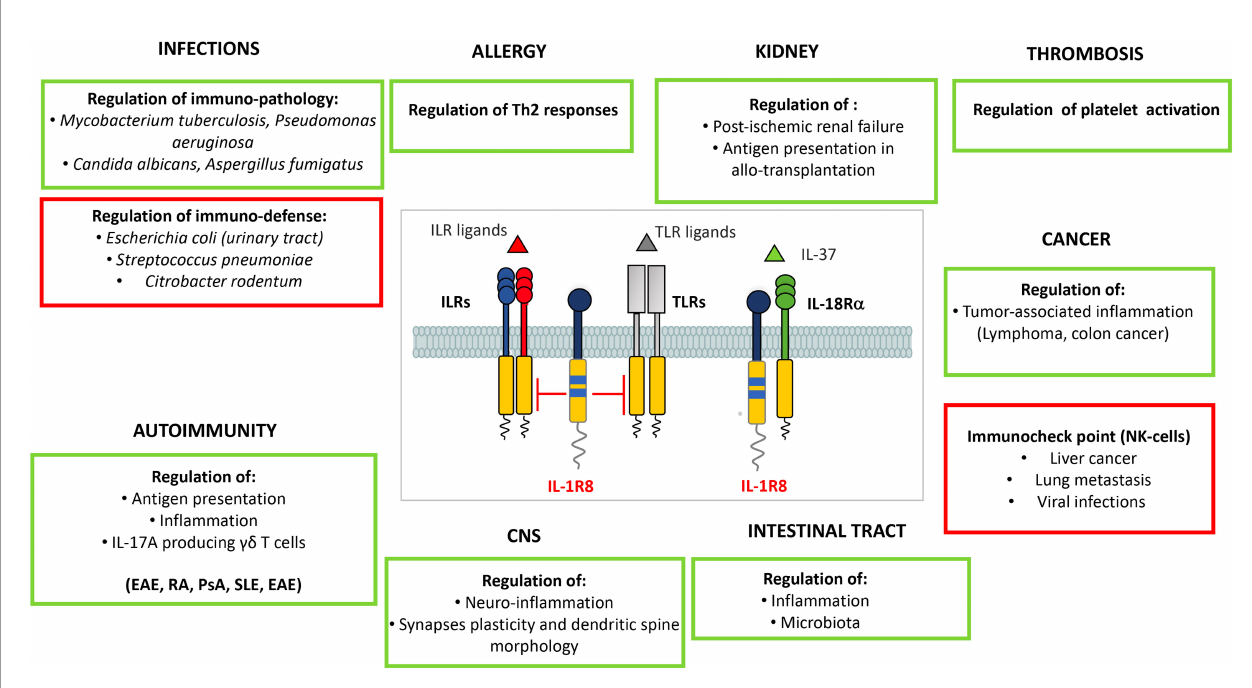
FIGURE 4 | Roles of IL-1R8 in pathology. IL-1R8 fi ne tunes innate and adaptive immune responses in different pathological conditions, thus acting as a key modulator of in fl ammation. IL-1R8 plays a non-redundant role in bacterial and fungal infections, allergy, autoimmune diseases, renal in fl ammation, thrombosis, neuro-in fl ammation and neuronal plasticity, intestinal in fl ammation, and cancer (colorectal cancer, breast cancer, prostate cancer and CLL). Recently, IL-1R8 has emerged as a novel checkpoint molecule in NK cells. In particular, IL-1R8 modulates maturation and activation of murine and human NK cells, thus regulating their antiviral and antitumor potential. In infections, IL-1R8 plays a dual role: in green, the conditions in which IL-1R8 has a protective role by preventing immunopathology; in red, the speci fi c infections in which by negatively tuning innate responses, IL-1R8 prevents the development of effective anti-microbial resistance. Similarly, in cancer, IL-1R8 tunes cancer-related in fl ammation in speci fi c tumors (in green), or acts as a checkpoint for NK cells, restraining their anti-tumor and anti-metastatic (and anti-viral)